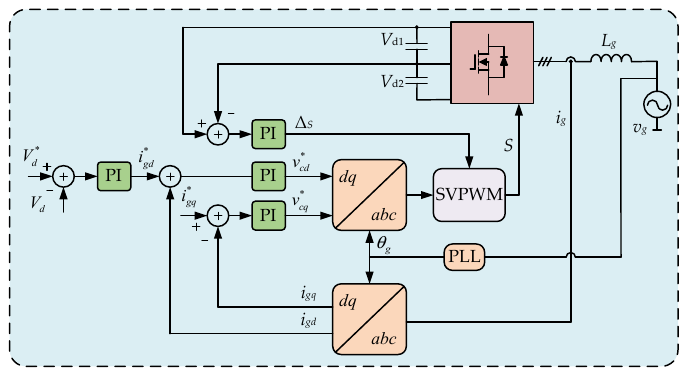
Figure 16. Voltage-oriented control block diagram of the three-level converter.